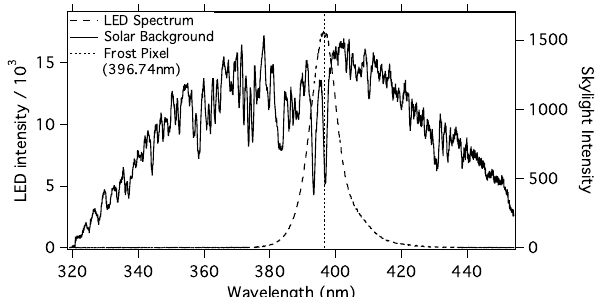
Fig. 3. Frost detection scheme example spectra. The dashed line shows the spectrum of the frost detection LED, while the solid line is an observed skylight spectrum. The frost detection wavelength, 396.7nm, is chosen to be at the base of the Fraunhofer dip to mini- mize skylight interference in the frost